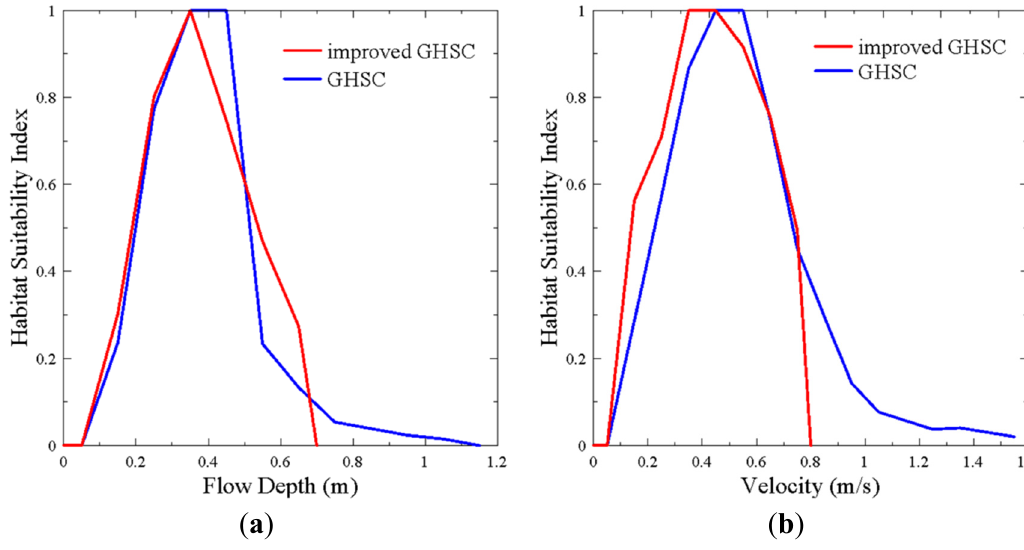
Figure 6. ( a ) Flow depth; ( b ) velocity. Generalized habitat suitability curves.